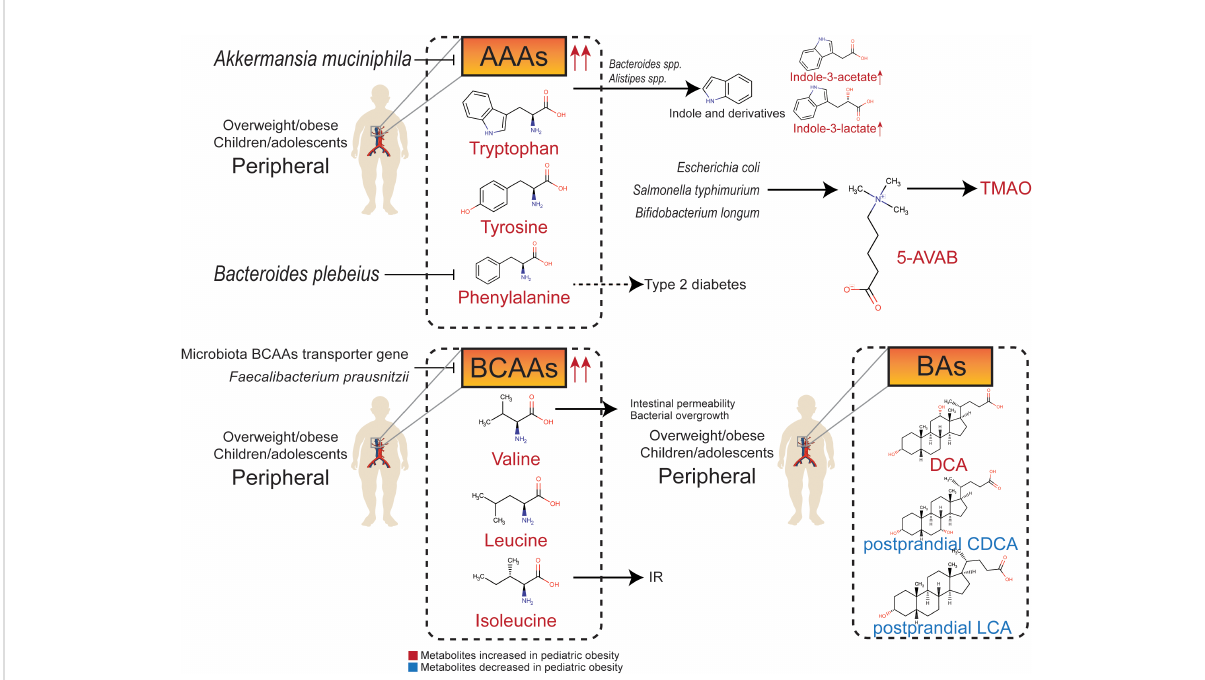
FIGURE 2 Relationship between gut metabolites (amino acids, amines, and bile acids) and pediatric